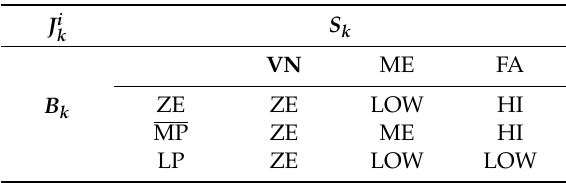
Table 3. Fuzzy rules for 𝑆 (cid:3038) , 𝐵 (cid:3038) and 𝐽